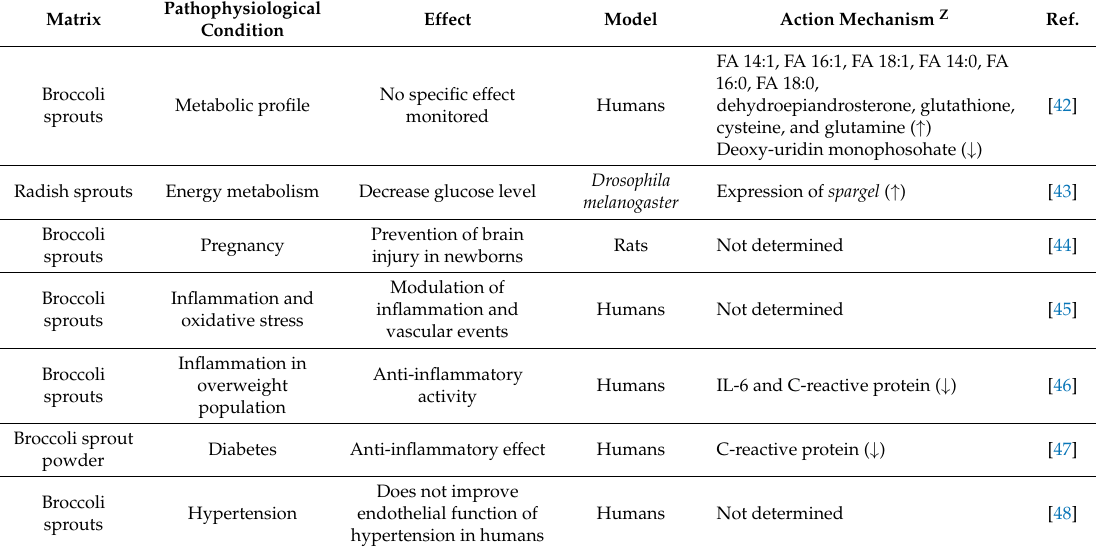
Table 3. Demonstrated health benefits of cruciferous sprouts under a range of pathophysiological